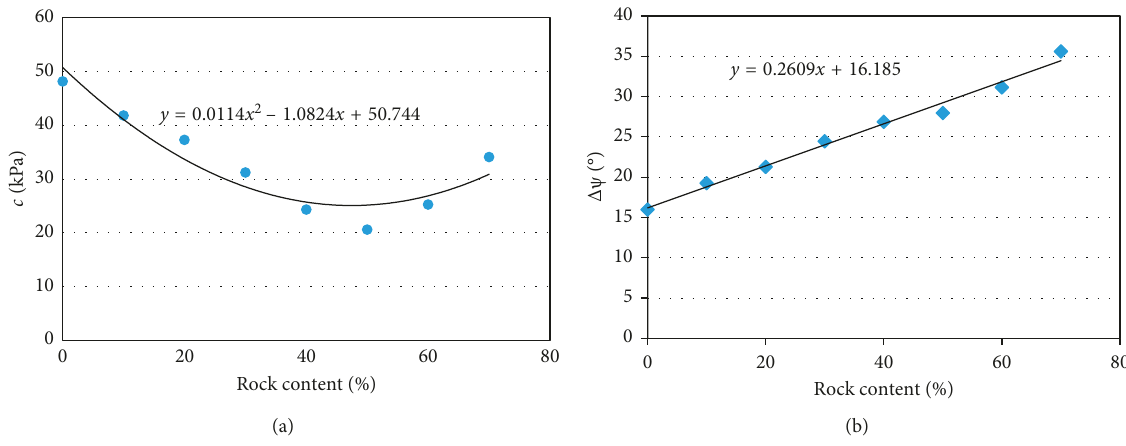
Figure 9: Variation laws of shear strength of soil-rock mixture with rock contents: (a) cohesion; (b) internal friction